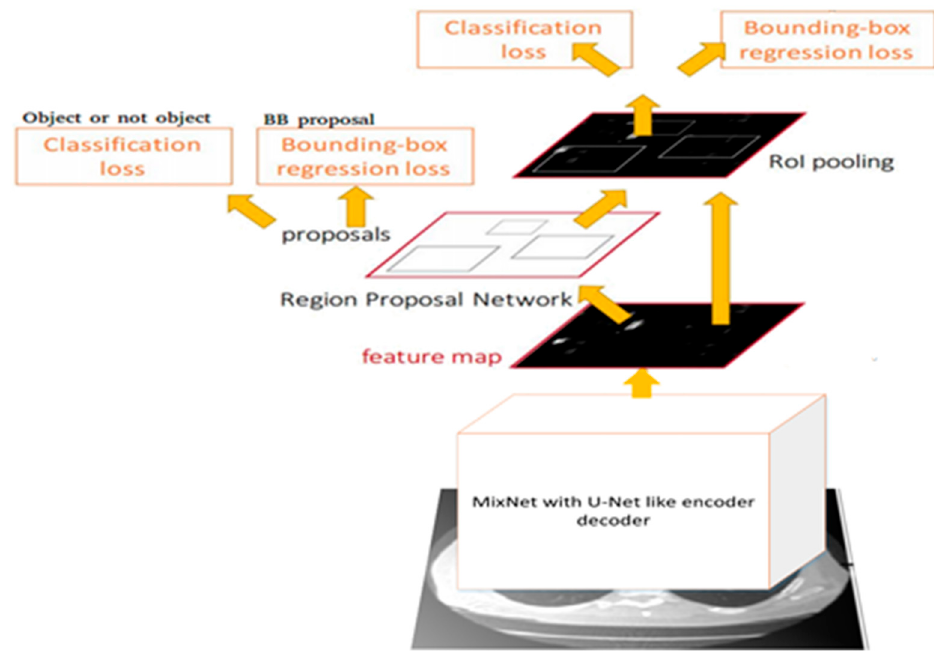
Figure 7. Nodule detection through Faster R-CNN.